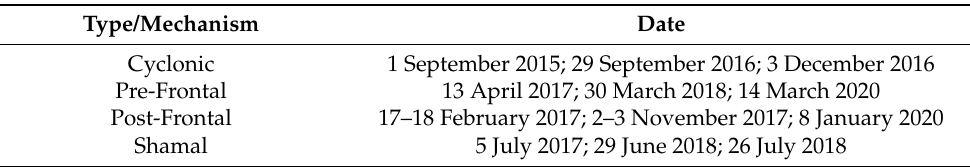
Table 1. Case studies of the synoptic dust events examined